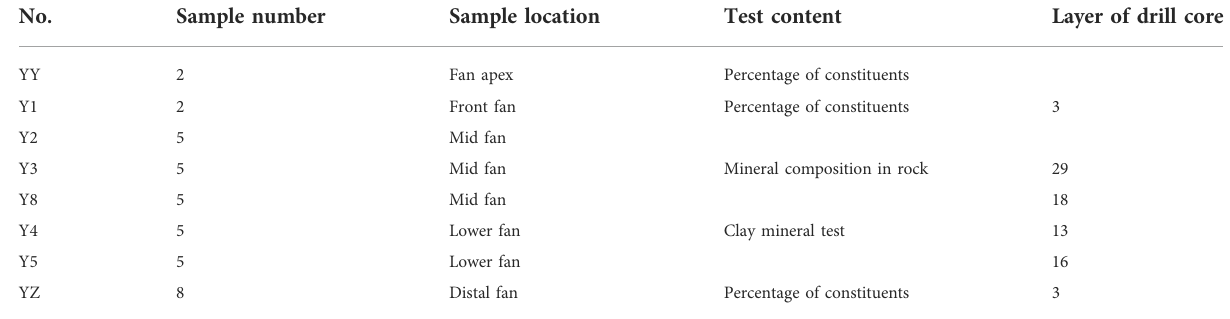
TABLE 1 Percentage of constituents and mineral composition in rock and